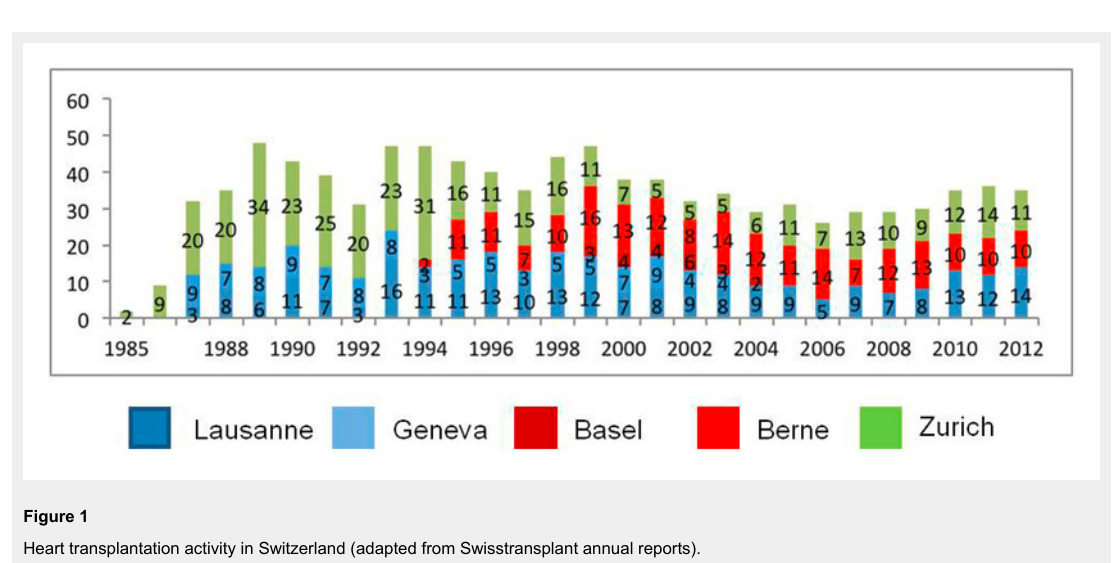
Heart transplantation activity in Switzerland (adapted from Swisstransplant annual reports).